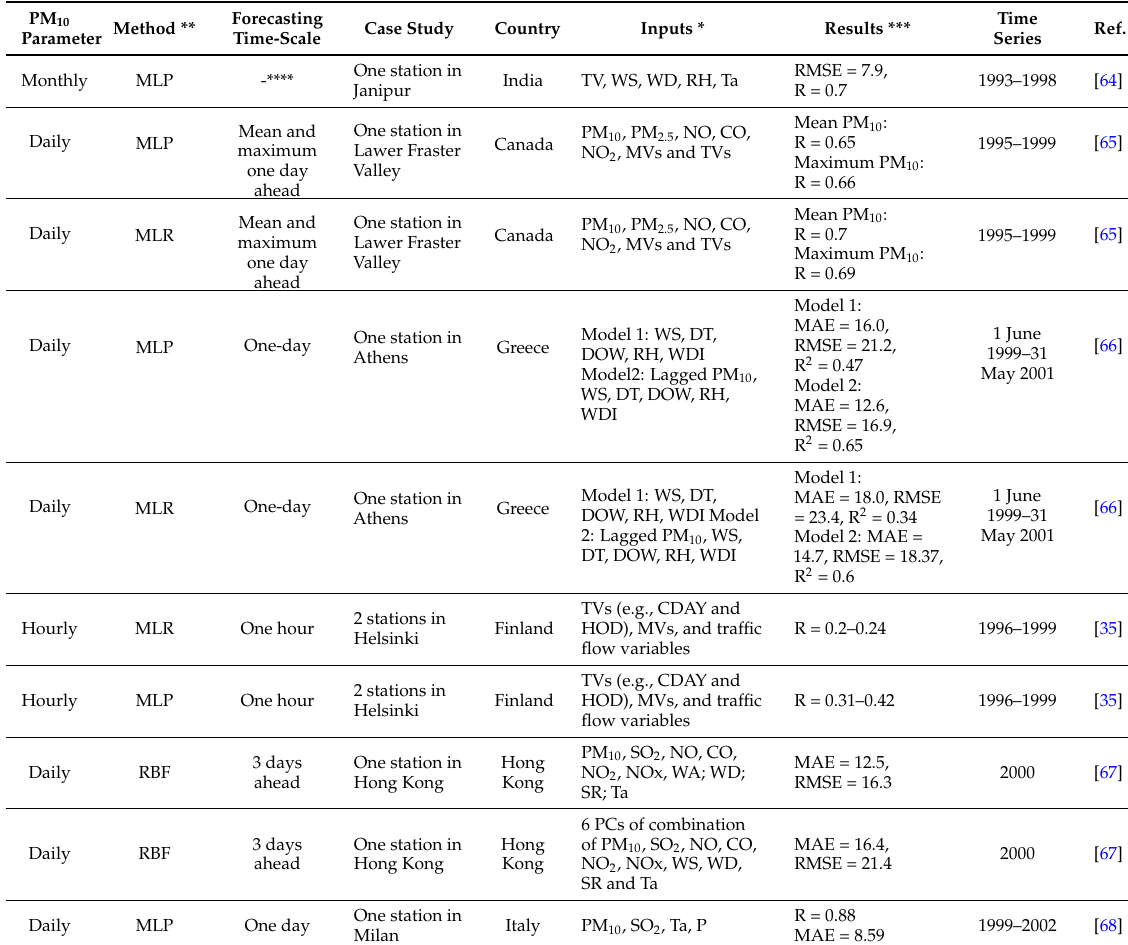
Table 1. Recent studies on PM 10 forecasting in one or more stations in urban areas, using MLR and ANN